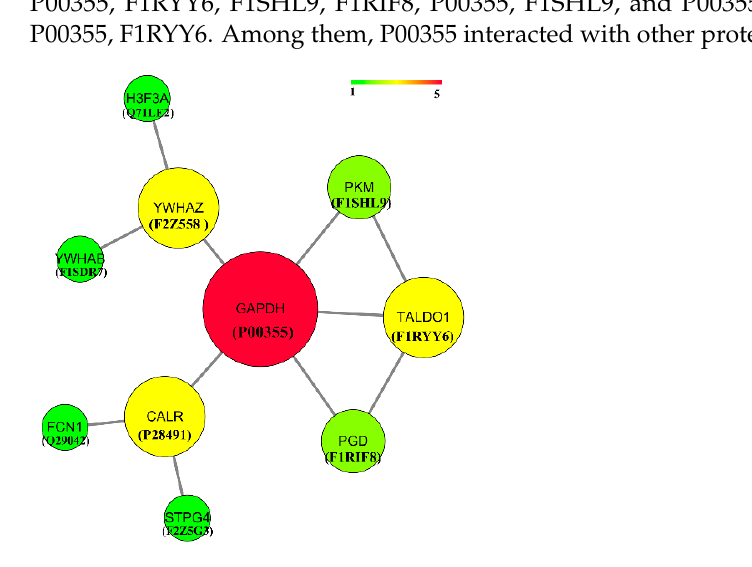
Figure 7. Analysis of salivary differential protein network interaction in estrus